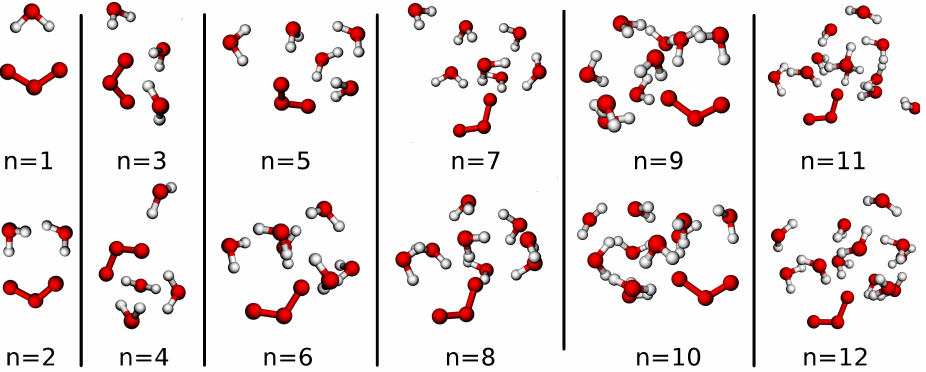
( H 2 O ) n clusters, n =1–12. The O − Fig. 4. Structures of the most stable O − ions are found near the surface of the clusters, but outside the 3 3 hydrogen bonded network. The solvent water adopt a clear shell-like structure, shown in Fig. 5. The charge on the central ion is partially delocalized, converging at ca. 0.82 e . See also Fig.